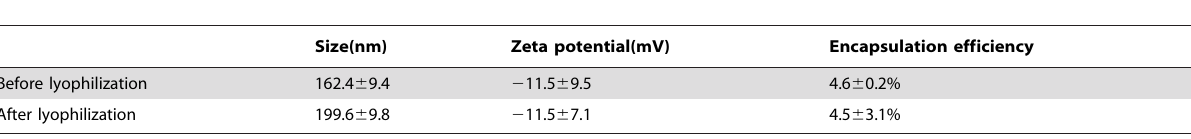
Table 1. Characteristics of 9NC encapsulated